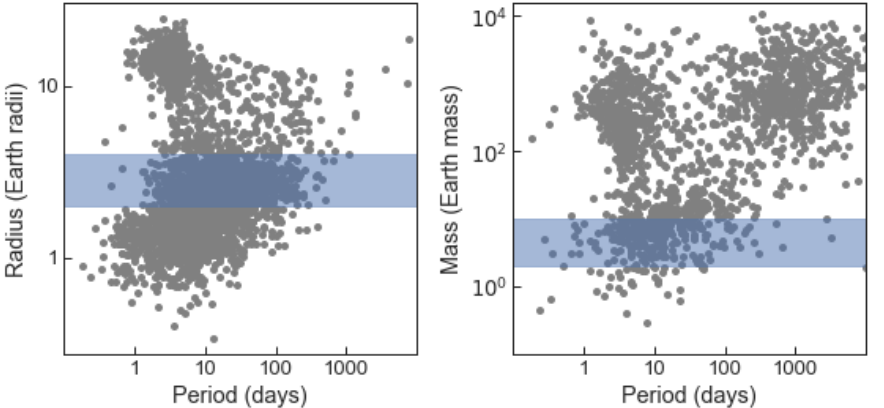
Figure 1. The known population of exoplanets with the sub Neptune exoplanets marked by the blue bands. The left (right) panel shows the planet radius (mass) in Earth radii (mass) versus orbital period in days. The blue-shaded region marks the typically adopted sub Neptune defining range of approximately 1.6–4 Earth radii (2 to 10 Earth masses). Only confirmed exoplanets are plotted, hence the data shown reflect selection and detection biases. Each panel shows slightly different samples of exoplanets because some planets have only mass or radius measured and not both. Data from Exoplanet archive (https://exoplanetarchive.ipac.caltech.edu/ (accessed on 28 January 2021).